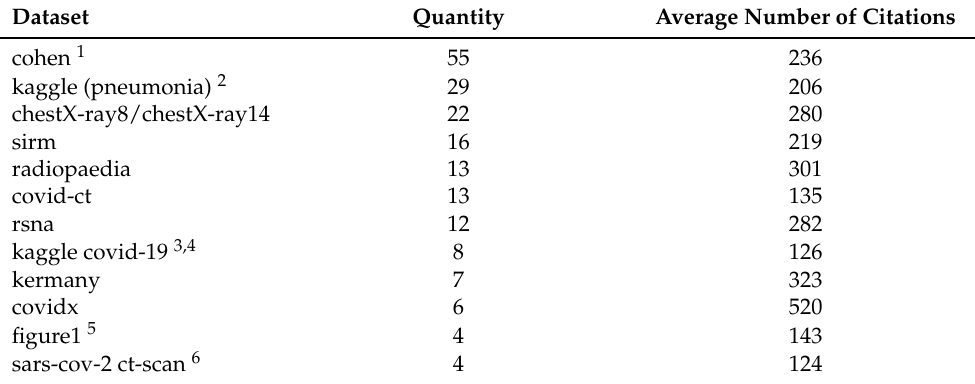
Table 5. Datasets frequently used to compose image collections.